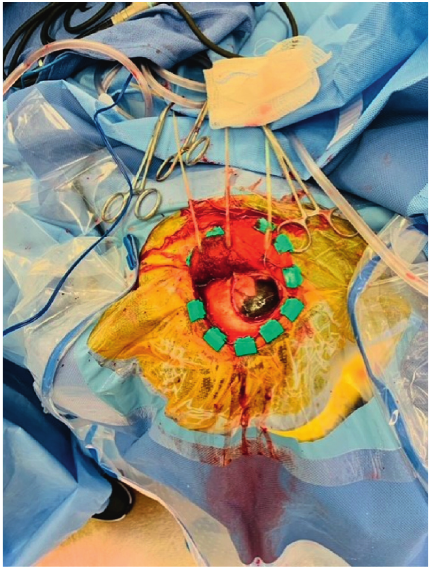
Figure 2: Brain biopsy procedure